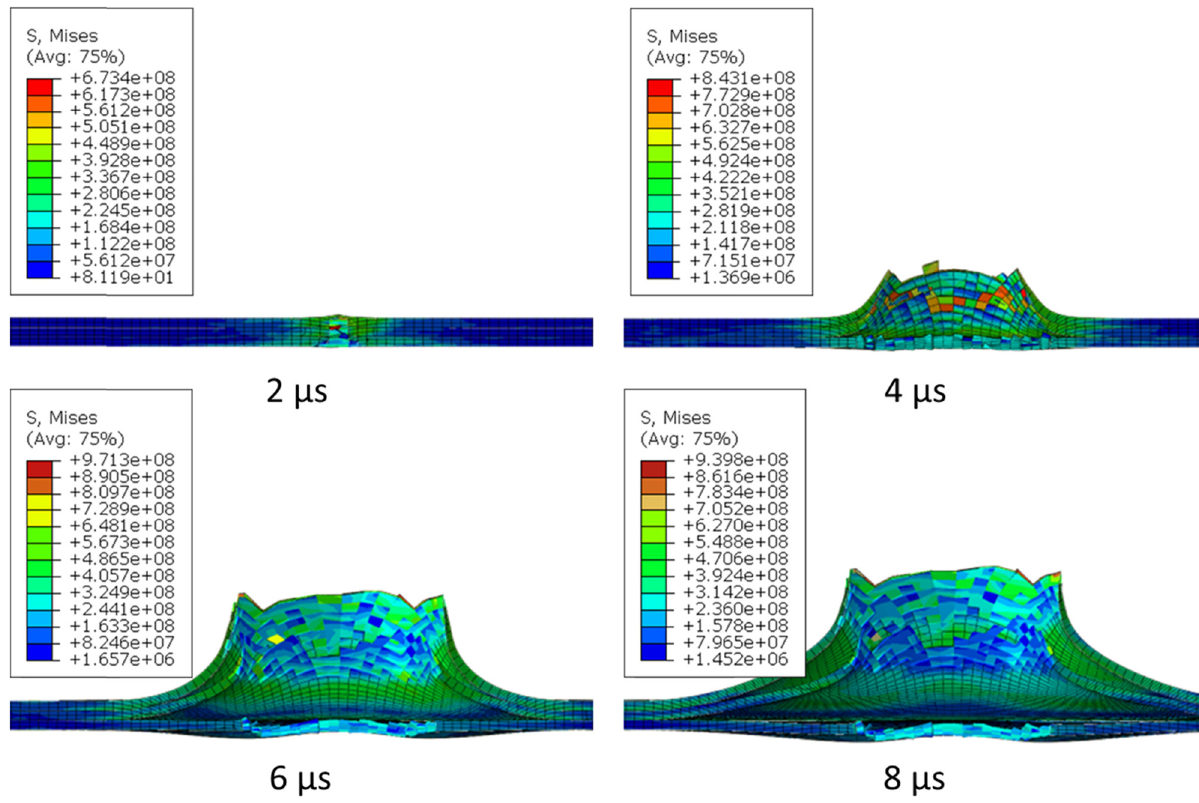
Figure 11: Stress distribution and deformation for model 3 against conical projectile.